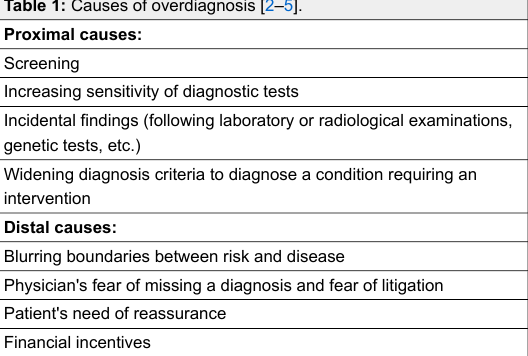
Table 1: Causes of overdiagnosis [2–5]. Proximal